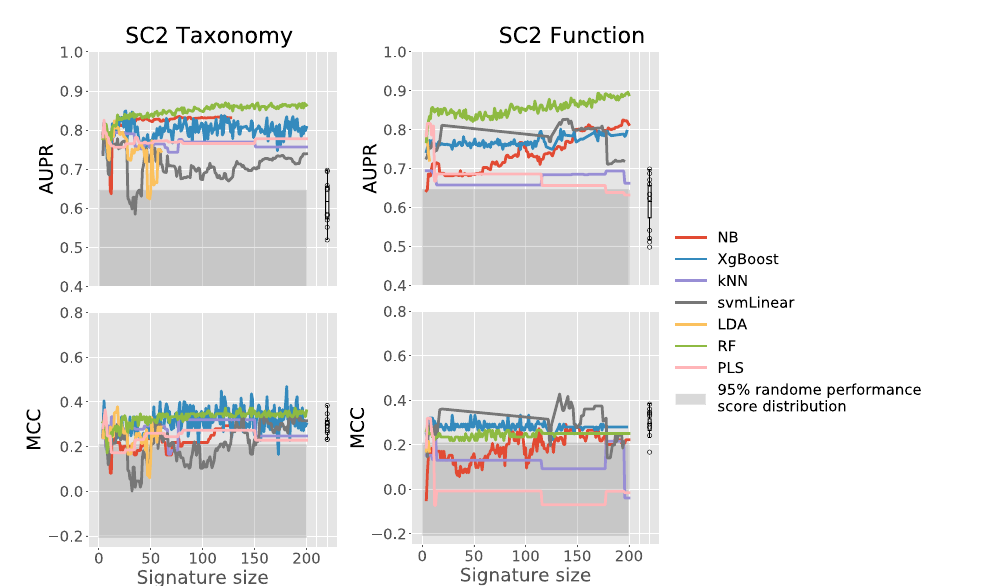
Figure 5. Classification performance of SC2 consensus signatures tested using seven in-house ML methods. Results are shown per metric and per SC2 data type. Each graphic also includes the boxplot showing the metric distribution for the individual SC2 predictions obtained for “IBD versus nonIBD” task and each data